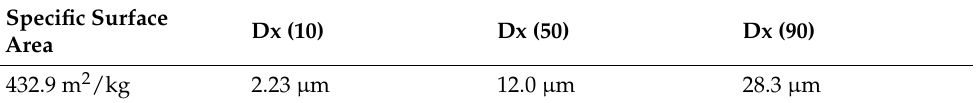
Table 2. Particle size distribution of slag.